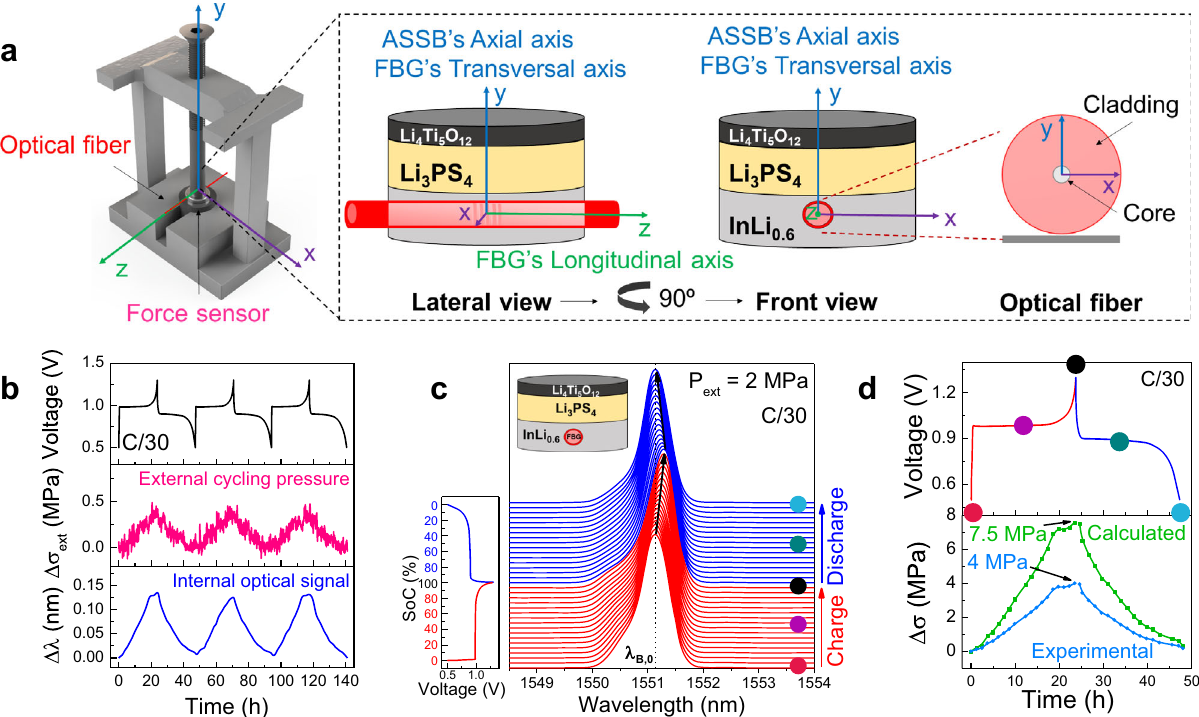
Fig. 4 Operando Li-driven stress monitoring in InLi x | LPS | LTO cell by an FBG embedded in the anode. a Scheme of the modi fi ed coin cell with the implemented optical fi ber and the external force sensor. The corresponding X -, Y- , and Z -axis are detailed in the different views. It is important to note that an axis transverse to the fi ber is an axis perpendicular to the main symmetry axis (c ∞ ) and therefore the axis “ axial ” to the cell is a “ transverse ” axis to the fi ber. To simplify nomenclature, every time we herein mention “ longitudinal ” or “ transversal ” will be respected to the fi ber and “ axial ” will only be respected to the cell. b Time-resolved voltage (top), external cycling pressure (middle), and an internal optical signal (bottom) for the aforementioned ASSB cycled at C/30 (5.83 mA g − 1 ) and 25 °C in an operando mode. c 2D stack view of the re fl ected spectra, with the corresponding galvanostatic charge/discharge cycle. The charge and discharge processes are plotted in red and blue, respectively. d Comparison between operando stress evolution obtained: 1 — internally by the FBG sensor and using the mathematical model (green curve) and 2 — internally by the FBG sensor and the sensitivity coef fi cient obtained with the experimental calibration of the sensor (blue curve). The respective galvanostatic charge/discharge is presented (top). The points at the beginning/middle/ end of the charge/discharge are indicated by colored dots, also marked in the corresponding FBG spectra in ( d ). The external cycling pressure was fi xed at 2 MPa prior to performing the battery